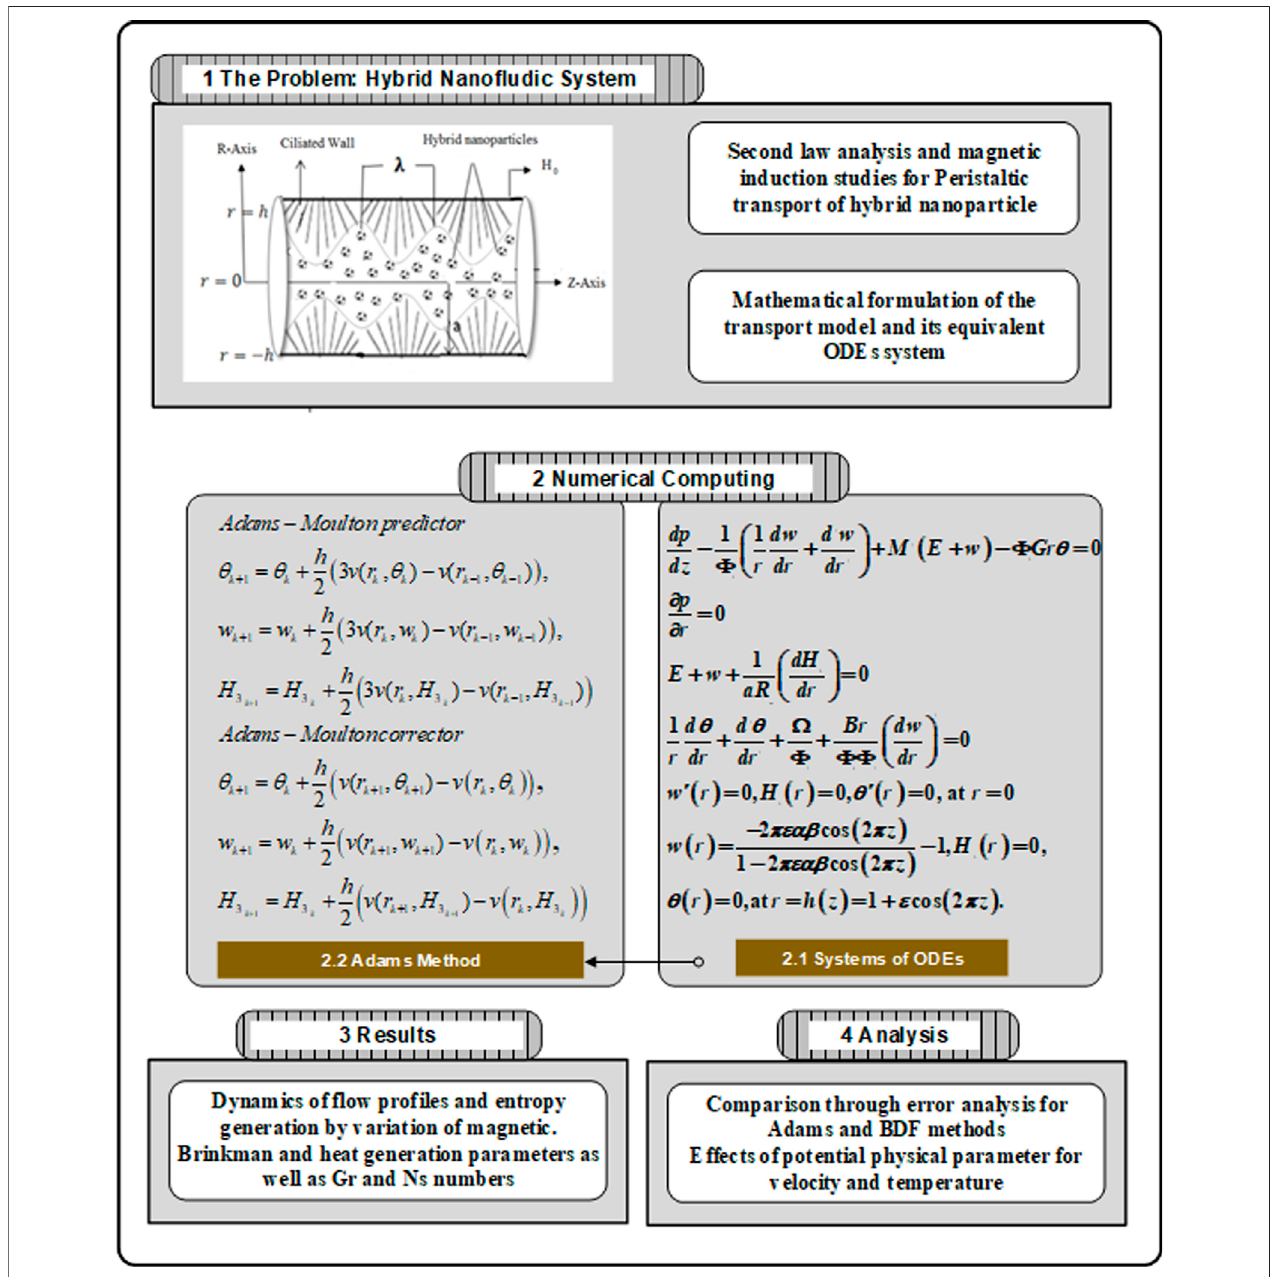
FIGURE 2 | Process block structure for solving the proposed hybrid nano fl uidic system.